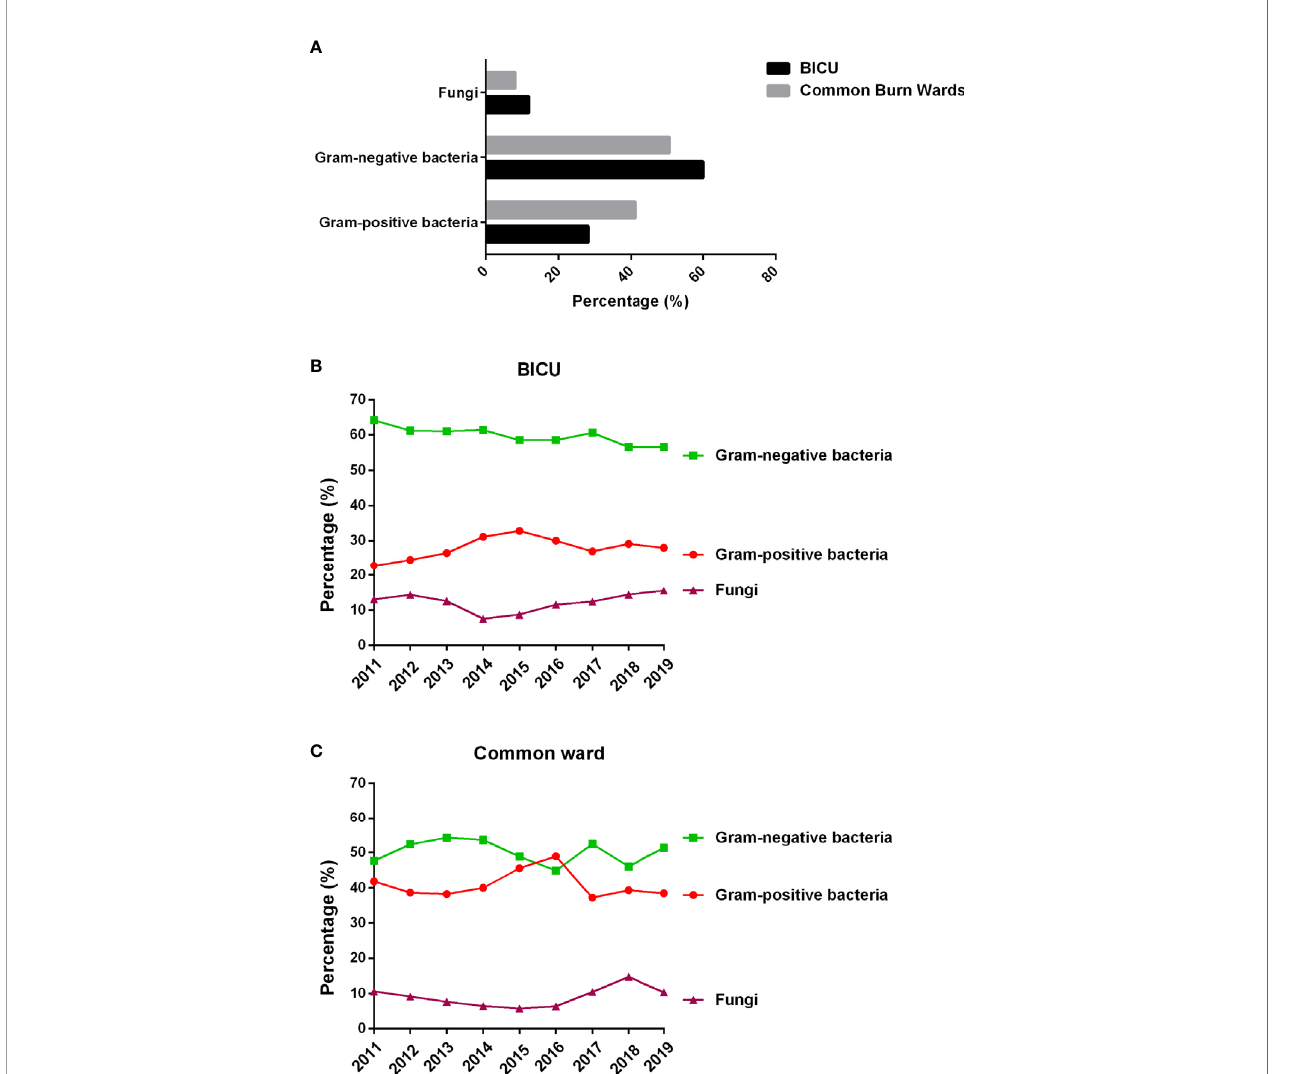
FIGURE 2 | Pathogen types in BICU and BCW. (A) The composition of different type of pathogens. (B) The changes of pathogen composition in BICU during 2011 to 2019. (C) The changes of pathogen composition in BCW during 2011 to 2019.